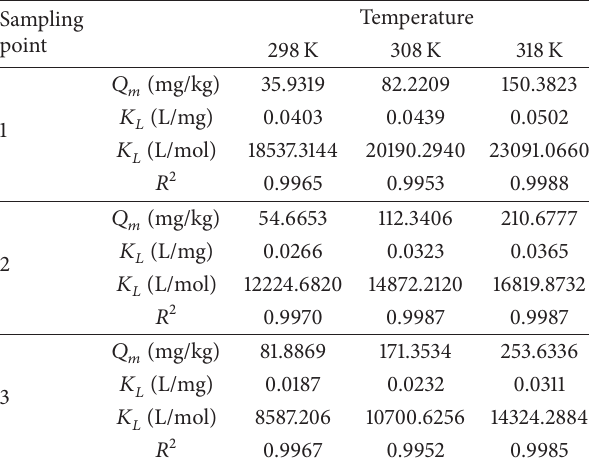
Table 5: Langmuir isotherm parameters for OTC adsorption onto sediment samples at different